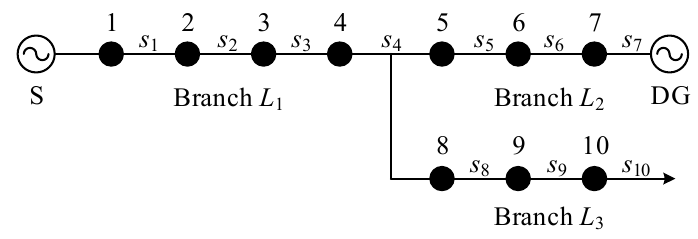
Figure 2. Typical active distribution network.